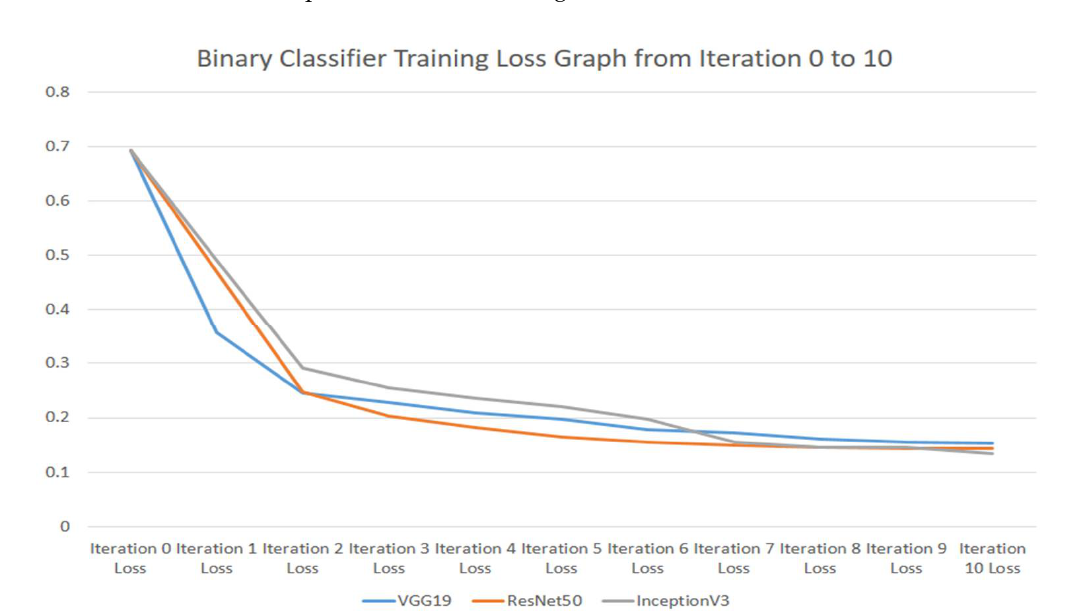
and InceptionV3 is shown in Figure 5.